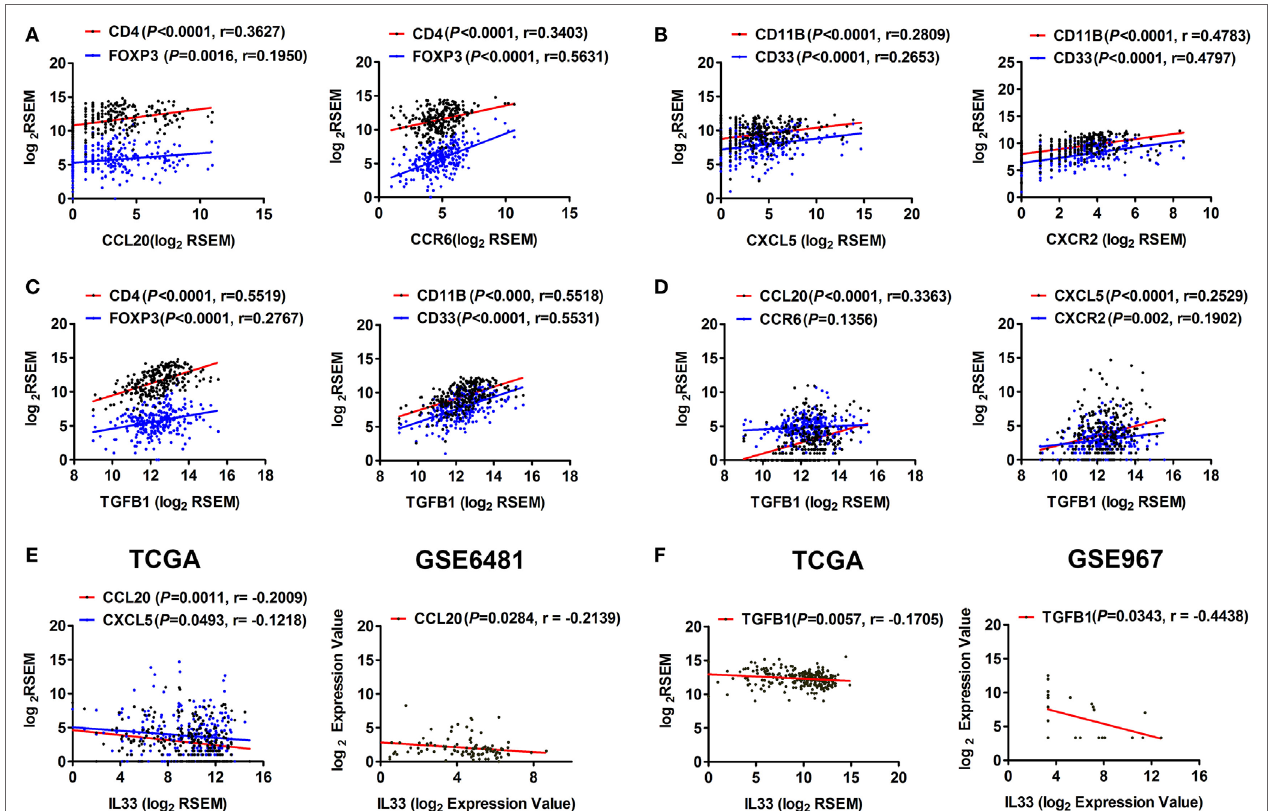
FigUre 5 | Correlation between the expression of IL-33 and TGF- β 1, chemokines that recruit Tregs and myeloid-derived suppressor cells in soft tissue sarcoma. (a) Positive correlations between the transcriptional levels of CCL20 and its receptor CCR6 and CD4/FOXP3. (B) Positive correlations between the transcriptional levels of CXCL5 and its receptor CXCR2 and CD11B/CD33. (c) Positive correlations between the transcriptional levels of TGFB1 and CD4/FOXP3 and CD11B/ CD33. (D) Positive correlations between the transcriptional levels of TGFB1 and CCL20, CXCL5, and CXCR2. Above analyses were performed using data from The Cancer Genome Atlas (TCGA). (e) Negative correlations between the transcriptional levels of IL-33 and the chemokines CCL20 and CXCL5 by analyzing sarcoma data of TCGA and GSE6481. (F) Negative correlation between the transcriptional levels of IL-33 and TGFB1 by analyzing sarcoma data of TCGA and GSE967. The correlation between gene expression levels was analyzed by Pearson correlation